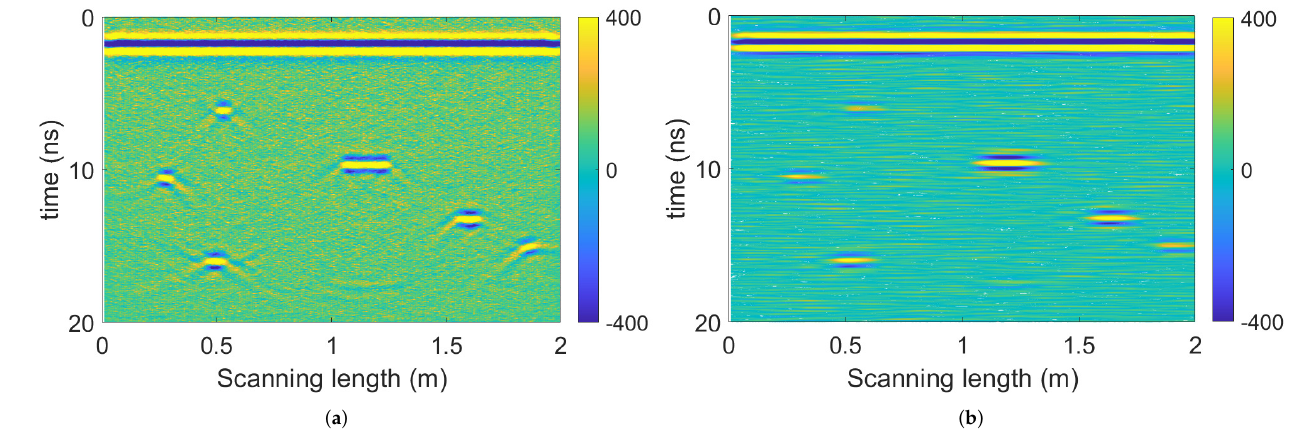
Figure 9. F-K migration results of ( a ) the polluted radargram and ( b ) the 4th-layer DH 4 . Scenario 3: identifying fractured rock areas with dense fissures Fissure groups other than the single throughout crack are common in fractured rock areas. A subterranean area with the measurement length 0 ≤ x ≤ 2 m and depth 0 ≤ z ≤ 1 m is simulated by ‘gprMax’. There are three predefined fractured rock portions with rock fissures randomly distributed inside (fissure widths of 5 mm, lengths of 1–5 cm, and intervals of 1–5 cm), as shown in Figure 10a. Other model parameters are the same as scenario 1. Figure 10b illustrates the corresponding radargram after pre-processing. Dense hyperbola tails have occupied large subsurface areas, affecting the identification of fractured rock areas.